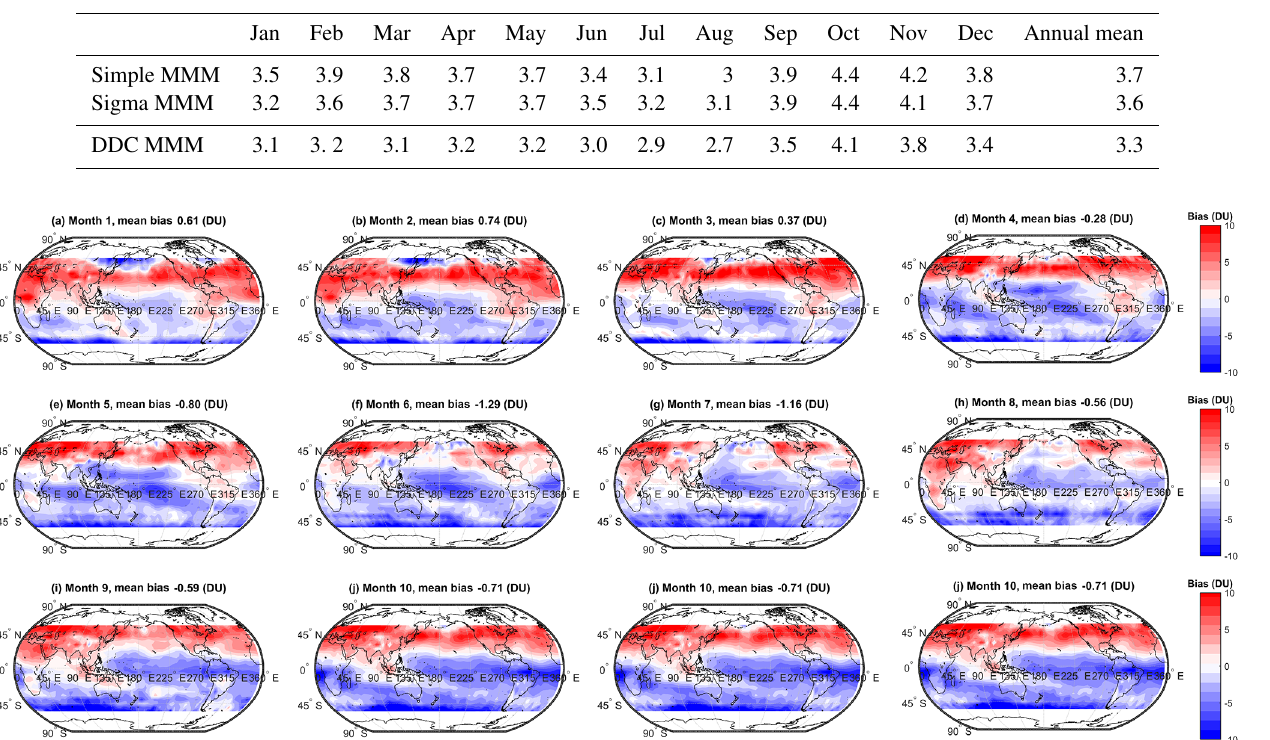
Figure 3. Monthly bias (DU) between the simple arithmetic multi-model mean (MMM) tropospheric ozone column and the observed clima- tology. Global mean values are